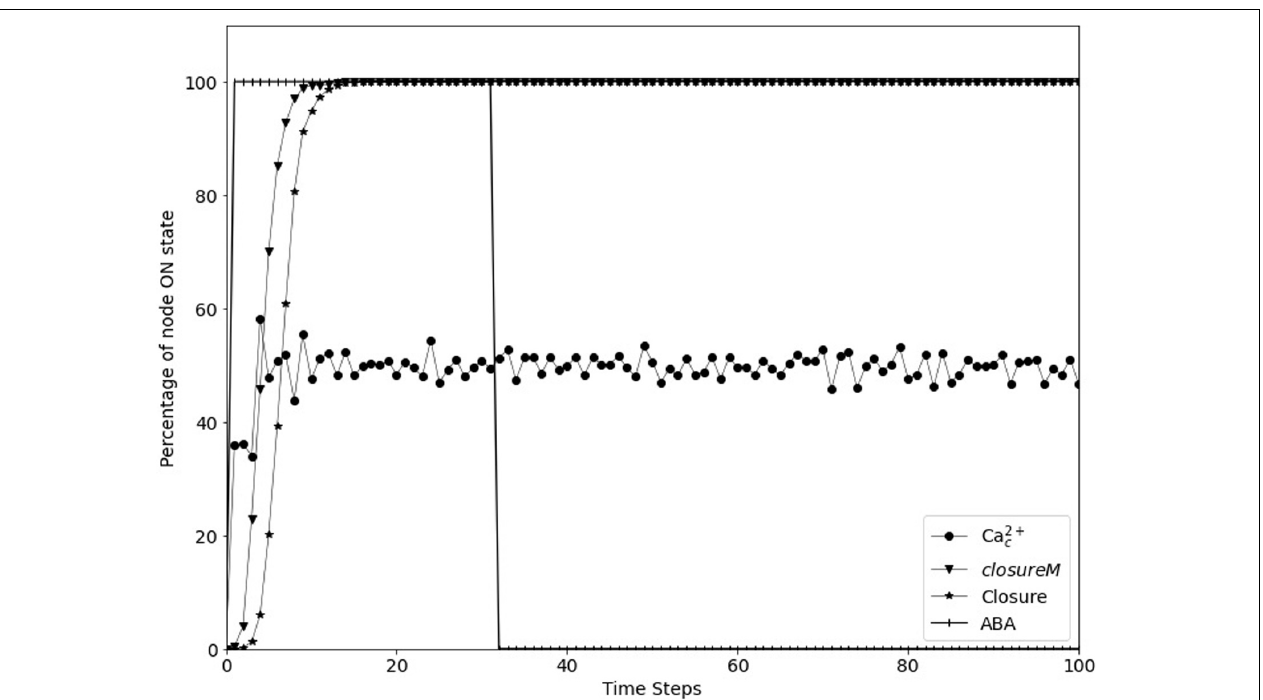
FIGURE 5 | Simulated stomatal closure is maintained after removal of ABA. The state of the node ABA (vertical line symbols) is ON for 30 time-steps and is then OFF. The closureM conditionally stable motif (downward pointing triangles) establishes in less than 15 timesteps and remains stable despite the loss of ABA. The percentage of closure (star symbols) increases to 100% and stays at this value even after the signal is removed. The circles represent the percentage of the ON state of Ca 2 + c which after a fast increase fluctuates around 50% since Ca 2 + c oscillates with approximately equal ON and OFF time periods. The biological expectation is that after the signal is removed the states of ROS, Closure, and Ca 2 + c should go to OFF